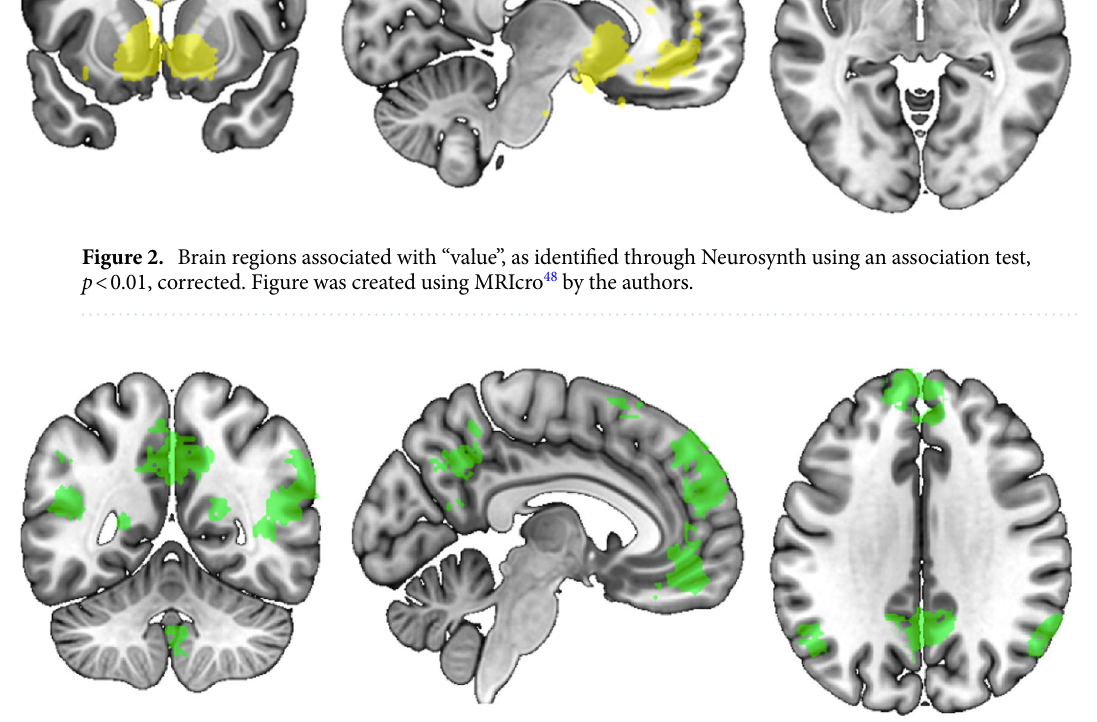
Figure 3. Brain regions associated with “mentalizing”, as identified through Neurosynth using an association test, p < 0.01, corrected. Figure was created using MRIcro 48 by the